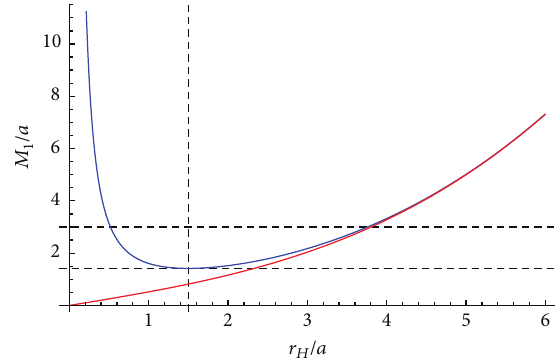
Figure 1: The blue curve corresponds to the relation equation (6) that gives the relation between the mass and the horizon of the extreme self-regular Schwarzschild-AdS black hole, and the red curve corresponds to the usual relation associated with the ordinary Schwarzschild-AdS black hole. When the horizon radius grows up, the two curves gradually approach, which means that the effect of noncommutativity mainly exists in the near extremal horizon. Here we set 𝑏 = 5𝑎 , which satisfies the hoop conjecture; see the analysis under (9) for the